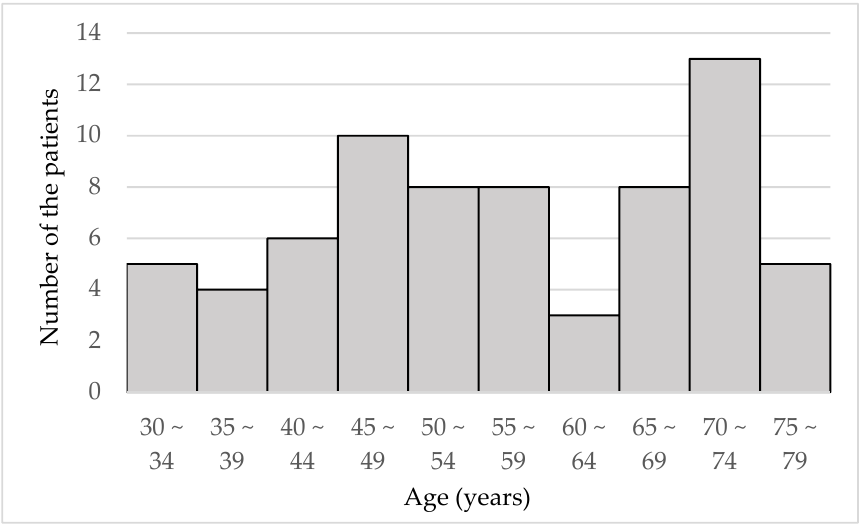
Figure 1. Distribution of patient age ( N = 70).